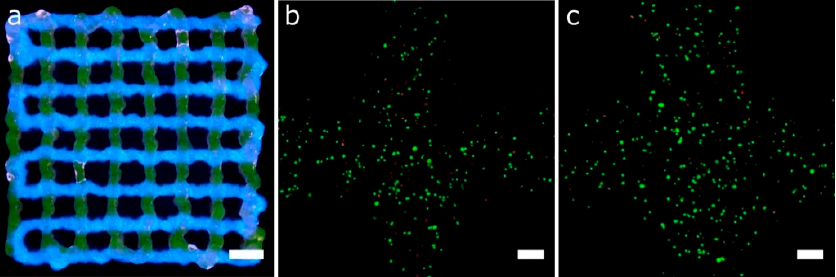
Figure 15. ( a ) general view of 2-layer porous lattice structure printed with Gel-Alg bioinks and two printheads. Each bioink was utilized for a different layer using a 25 G nozzle (scale bar: 2 mm). ( b , c ) Representative confocal images of cell viability assay of printed hASCs using the same Gel-Alg mixture and printing parameters than that of ( a ) but without fluorescence inks at 1 h ( b ) and 24 h ( c ) post-printing (scale bars: 200 μ m).